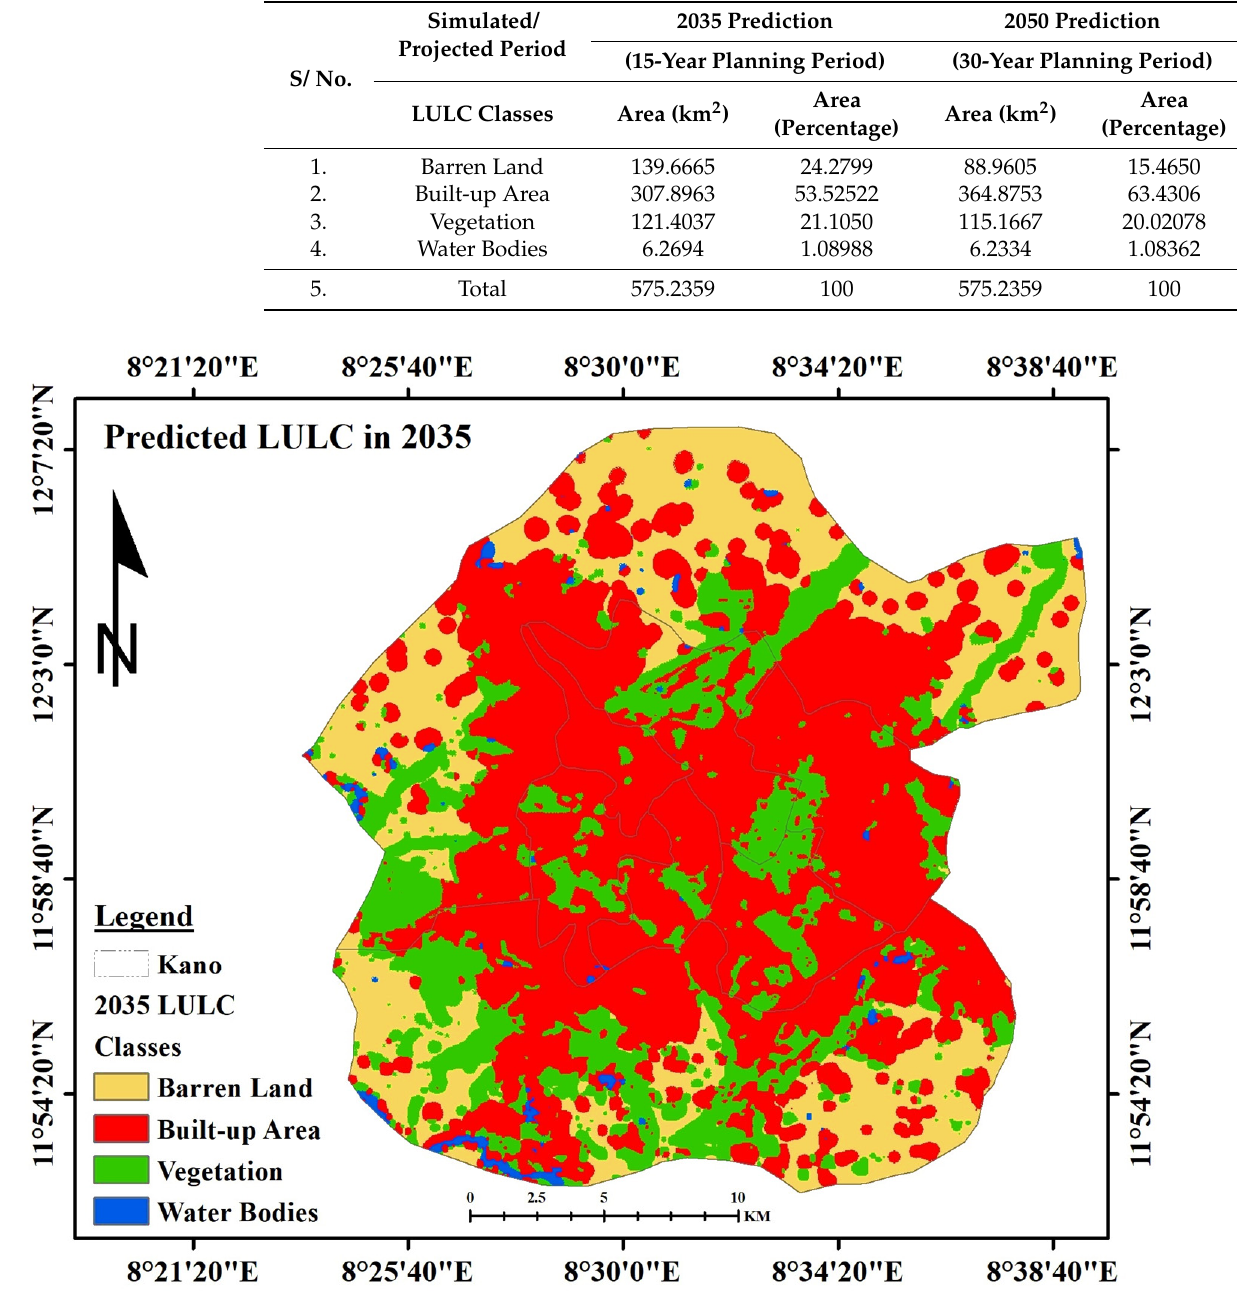
Figure 8. Mapping of predicted LULC in 2035.